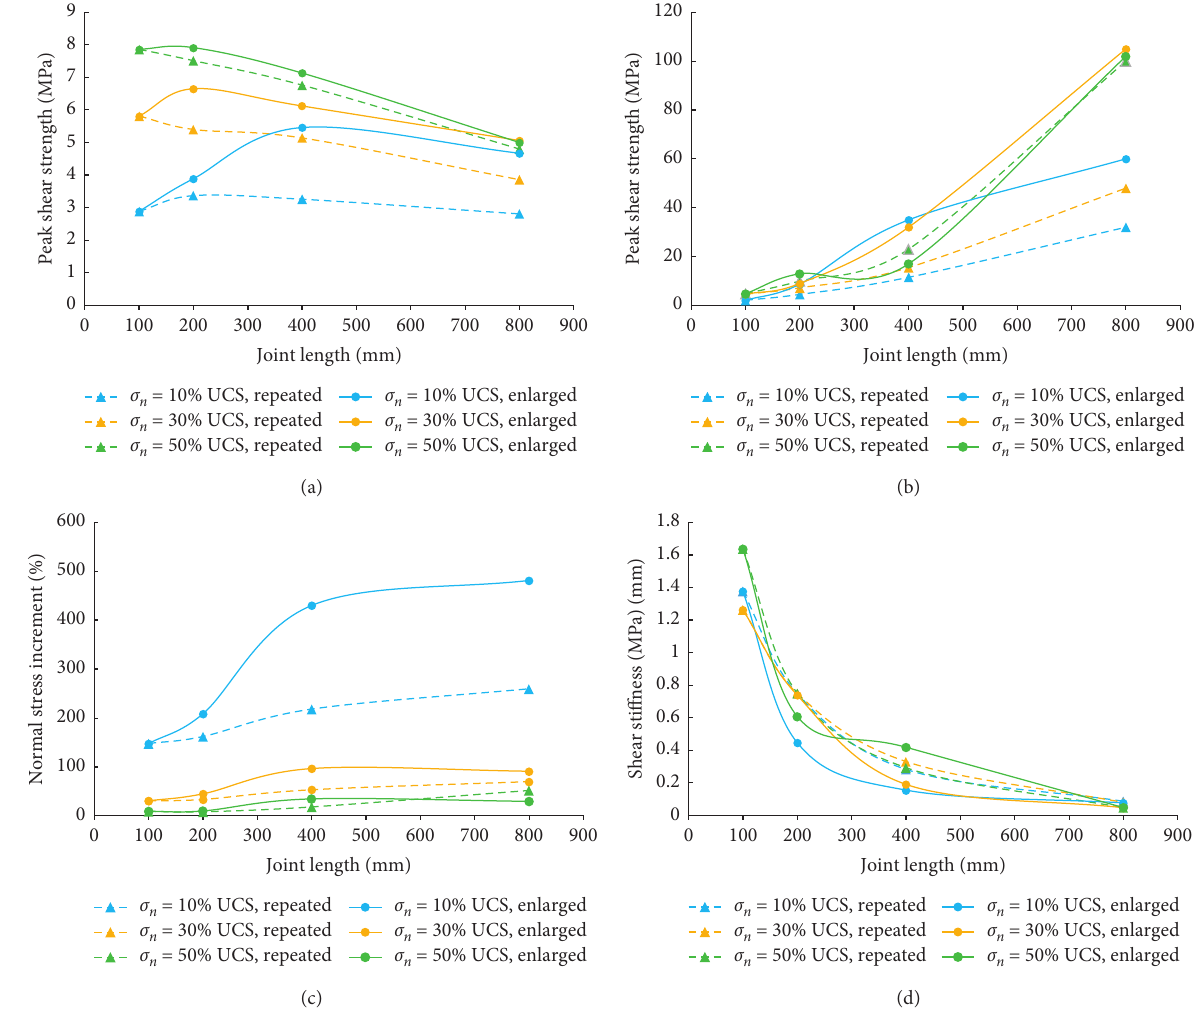
Figure 11: Shear behavior of different-sized repeated and enlarged joints under CND condition. (a) Peak shear strength. (b) Peak shear displacement. (c) Normal stress increment. (d) Shear